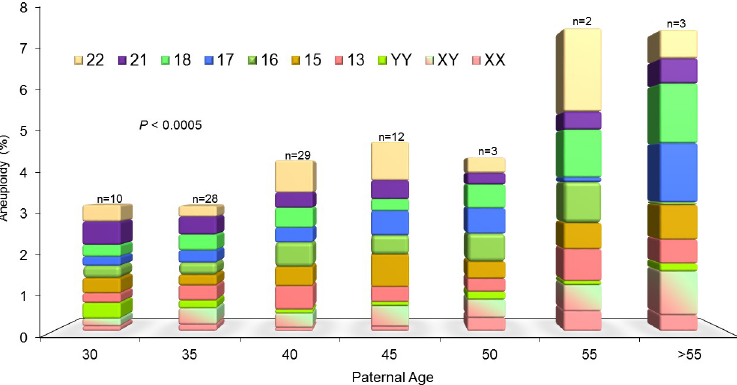
Fig 2. FISH aneuploidy assessment by individual chromosomes in relation to advancing male age. Of particular note were chromosomes 15 (orange) and 17 (blue), which progressively increased with age, while chromosome 21 (purple) was noticeably highest in the youngest age group, progressively decreasing with advancing male